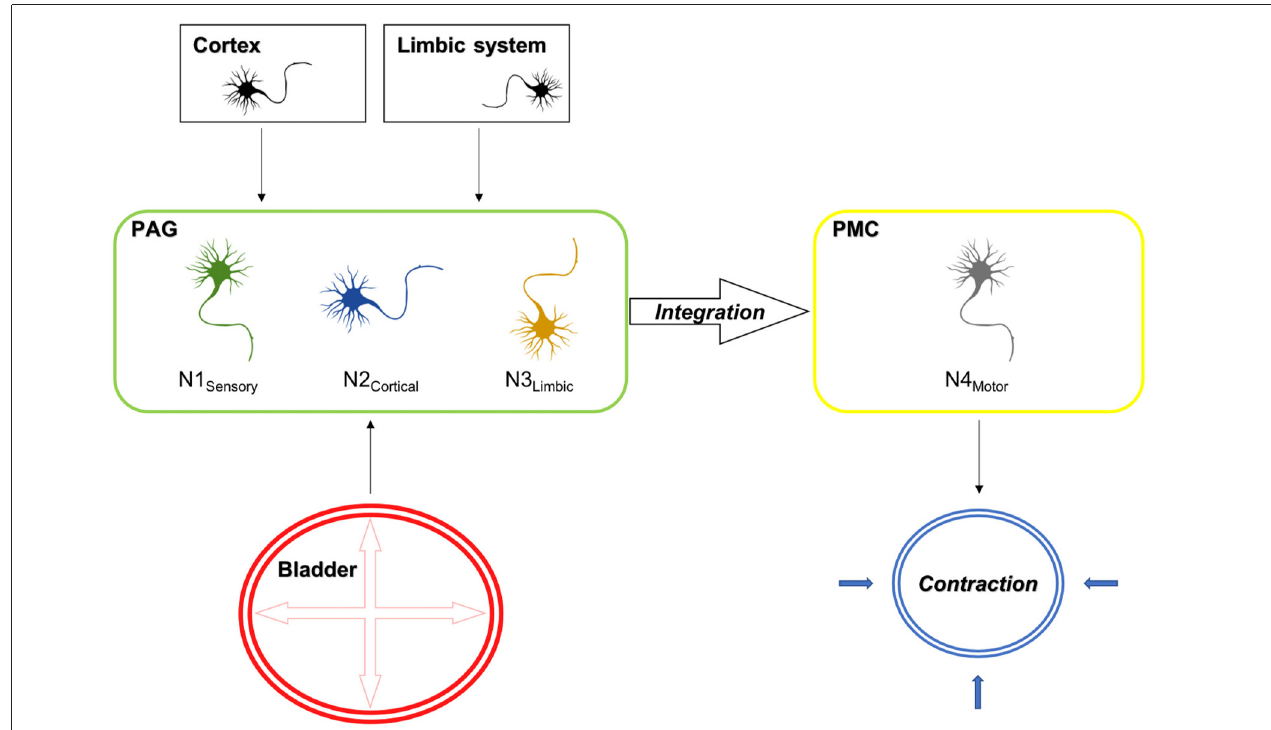
FIGURE 9 | Electrical stimulation mimicking stretch of the detrusor muscle leads to the activation of sensory bladder afferents (A δ fibers), which in turn activate sensory neurons in the PAG (N1 sensory). Besides, the PAG receives cortical and limbic input, which evaluates external circumstances, which either inhibit or facilitate voiding and activate cortical (N2 cortical) and limbic (N3 limbic) projection neurons in the PAG. The integration of these signals takes places in neurons projecting to the PMC. In turn the PAG releases its disinhibitory action on the PMC, which results in the activation of efferent neurons (N4 motor), which result in the corresponding action at the spinal cord, leading to detrusor contractions and the relaxation of the external urethral sphincter, which are prerequisites for voiding. Also shown is the activation pattern as assessed by cFos expression in the D-N configuration for the rostral and caudal PAG. Red areas indicate activation and green areas are not activated upon sensory afferent